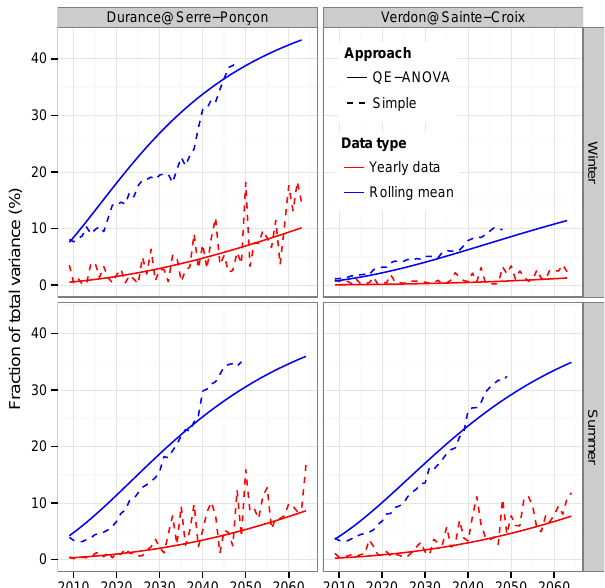
Figure 12. Fraction of total uncertainty due to HMs computed from the QE-ANOVA and a simpler approach (see text for details), for both yearly anomalies and changes in 30-year rolling